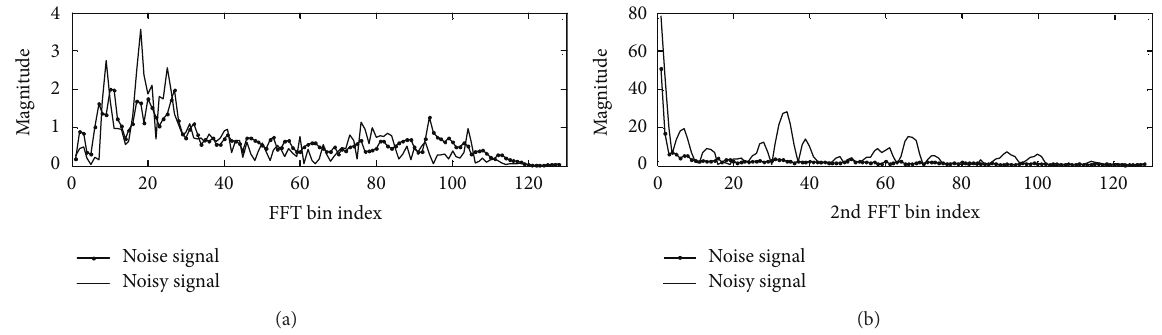
Figure 4: Difference in patterns of 1st FFT and 2nd FFT: (a) pattern of noisy speech signal and pattern of noise signal after 1st FFT and (b) pattern of noisy speech signal and pattern of noise signal after 2nd